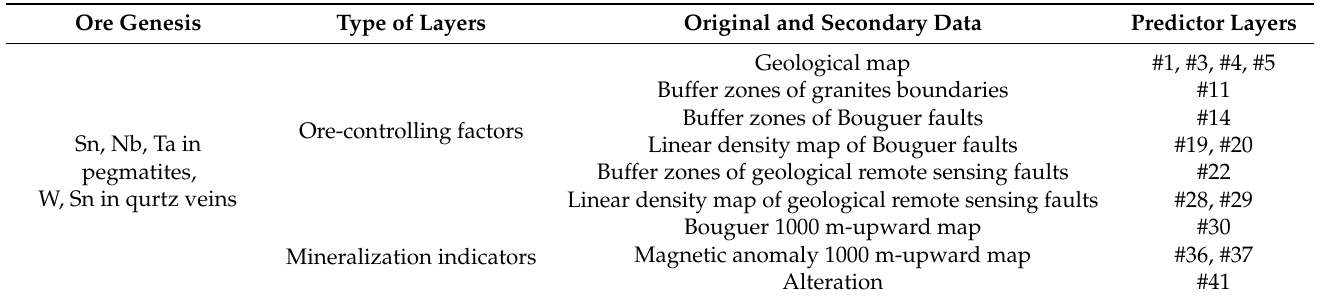
Table 5. Predictive model of Nb-Ta mineralization in